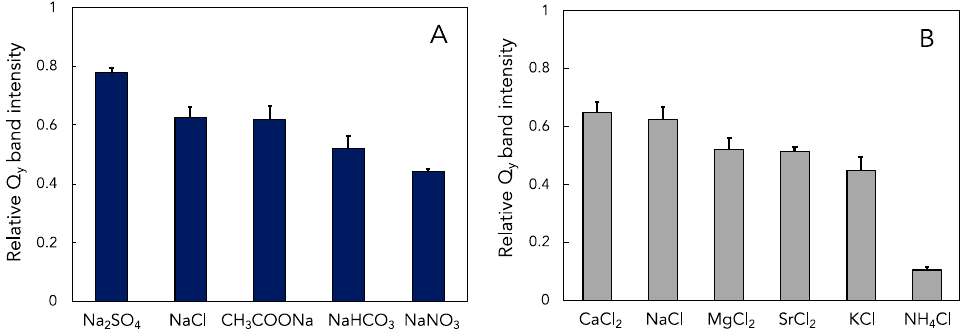
Figure 3. The relative Q y band intensities of the Hlr. halochloris LH1-RCs in the presence of 500 mM of various sodium salts ( A ) or chlorides ( B ) after incubation at 45 °C and pH 8 for 60 min.